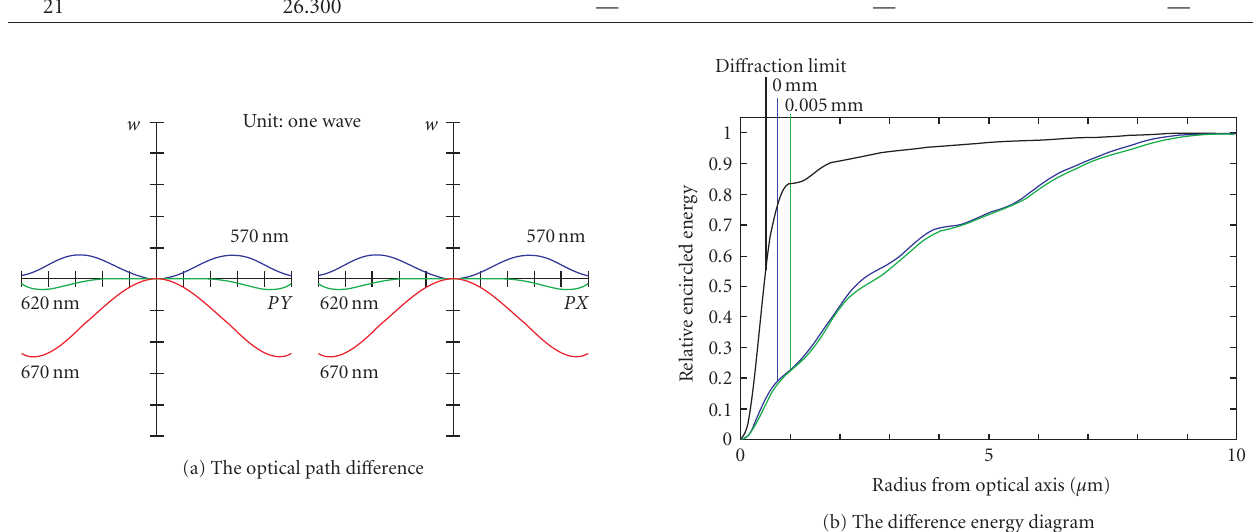
(b) The di ff erence energy diagram